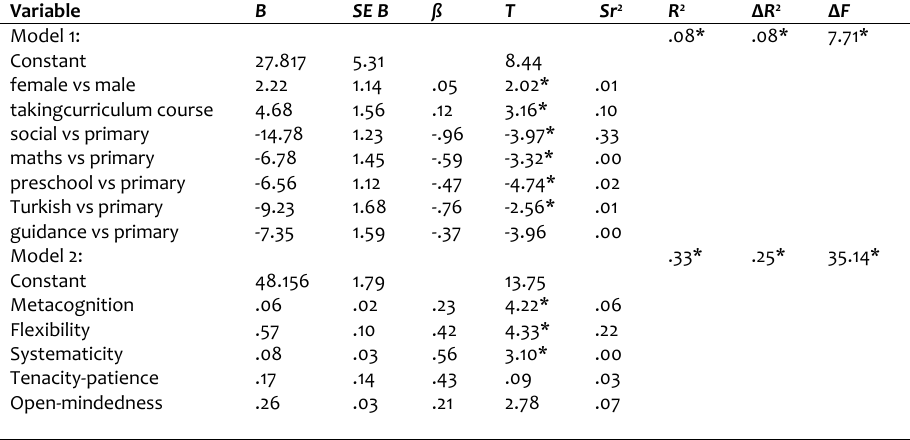
Table 4. Hierarchical multiple regression analysis for variables predicting curriculum literacy Variable B Model 1: Constant female vs male takingcurriculum course social vs primary maths vs primary preschool vs primary Turkish vs primary guidance vs primary Model 2: Constant